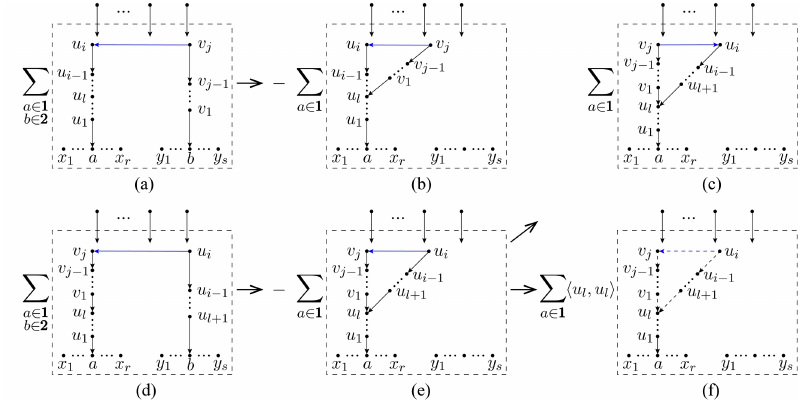
Figure 8 . A pair of graphs (b) and (e) in category-2, which come from the expansions of spanning forests (a) and (d), cancel each other out by applying transformation-1 to graph (e). Graphs (c) and (f) are the two graphs transformed from (e).